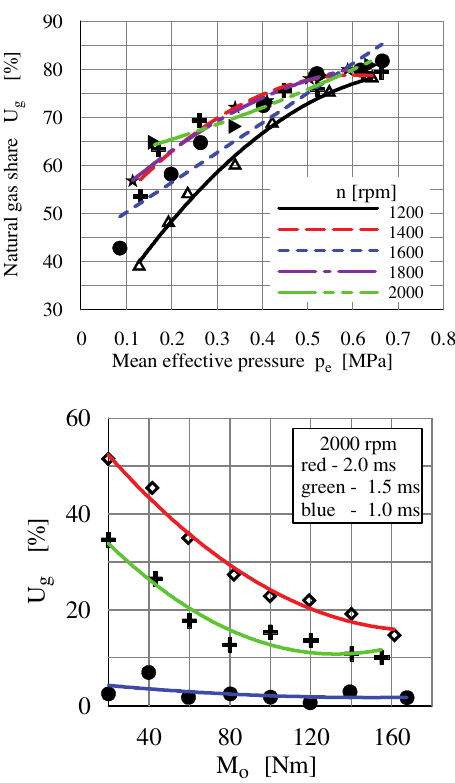
Fig 3. Influence of engine load on energetic share of gas in total dose of energy supplied to the engine: a) SB3.1 engine, different engine speeds, initial dose q = 19.8 mm3/cycle, injection advance angle 22oCA before TDC; b) Fiat 1.3 MJT engine, variable opening time of gas